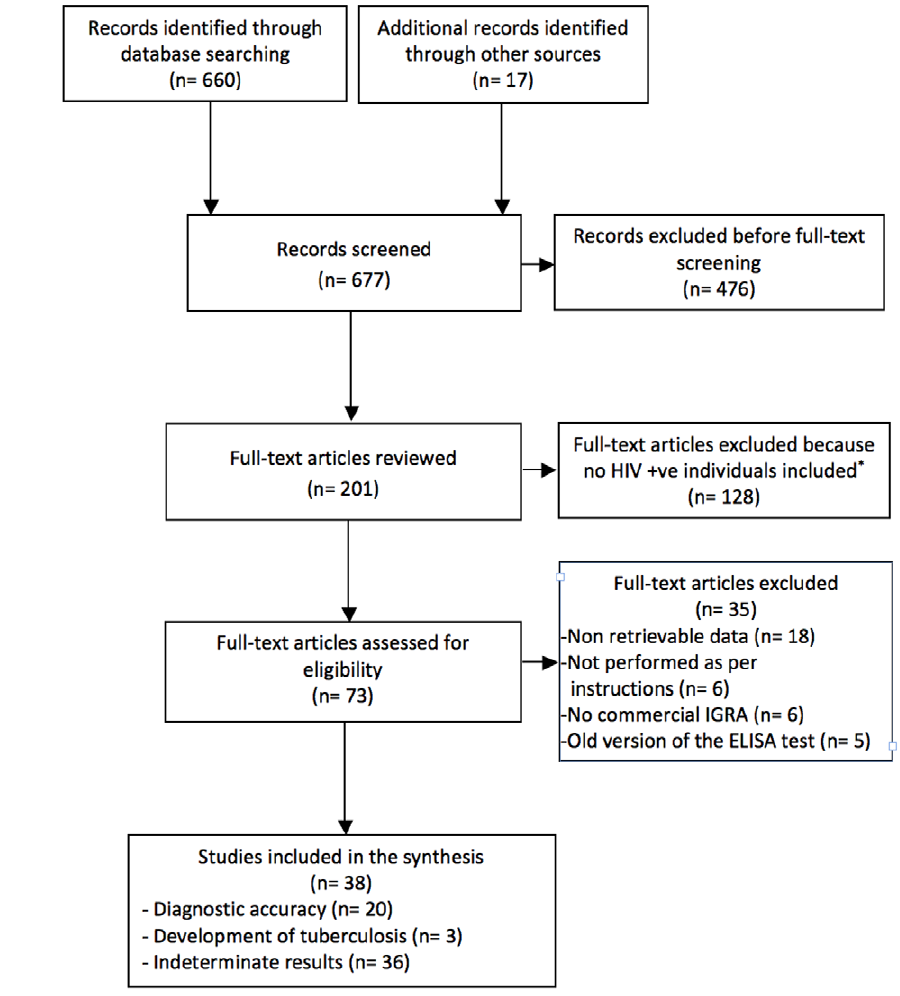
Figure 1. Flowchart for study selection.